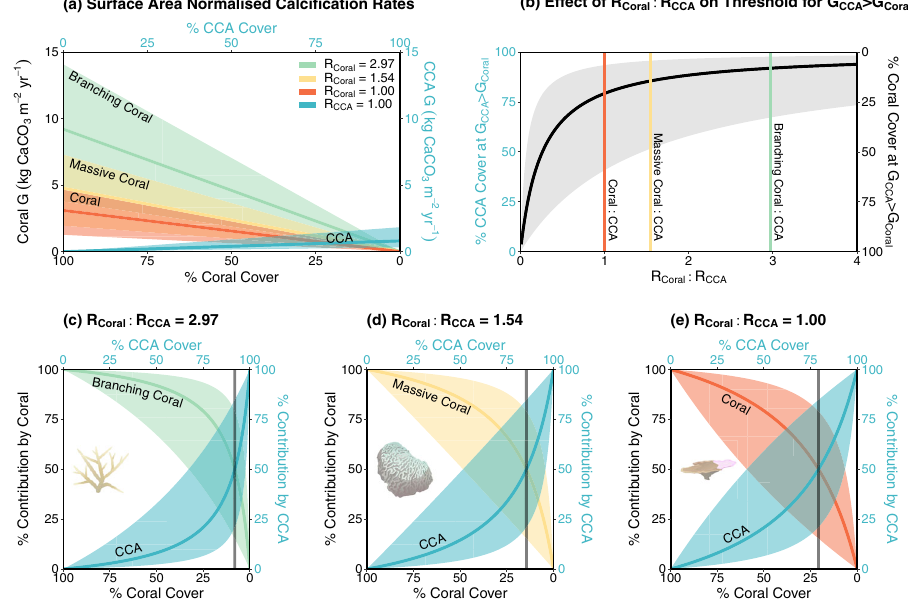
Fig. 4 Simulated tradeoffs between CCA and coral carbonate production. (G, kg CaCO 3 m − 2 y − 1 ) for reefs dominated by scleractinian corals vs CCA (i.e., % Coral + % CCA = 100%). a Surface area-normalised calci fi cation rates (median ± interquartile range) from a literature search of CCA and coral calci fi cation rates normalised to surface area of growing tissue scaled to reefs ranging from 100% coral cover to 100% CCA cover (blue) with additional lines considering structural complexity multiplier factors for branching corals (green), massive corals (yellow), and encrusting corals (red). b Simulates the % cover of CCA (median ± interquartile range, left axis) required to contribute more CaCO 3 than the remaining % cover of scleractinian corals (median ± interquartile range, right axis) for a range of structural complexities (0 ≤ R Coral :R CCA ≤ 4). Vertical lines represent scenarios for branching (green), massive (yellow), encrusting corals (red), or any scenario where R Coral = R CCA (red). c – e Show the % contribution by CCA and c branching corals growing over planar CCA, d massive corals growing over planar CCA, and e encrusting corals growing over planar CCA or any scenario where corals have the same rugosity as CCA for a simulated benthic community ranging from 100% coral cover to 100% CCA cover. Vertical grey lines indicate the threshold where CCA carbonate production is equal to coral carbonate production. See methods for further details on the conceptual model. Coral icons are courtesy of the Integration and Application Network, University of Maryland Center for Environmental Science (ian.umces.edu/symbols/).